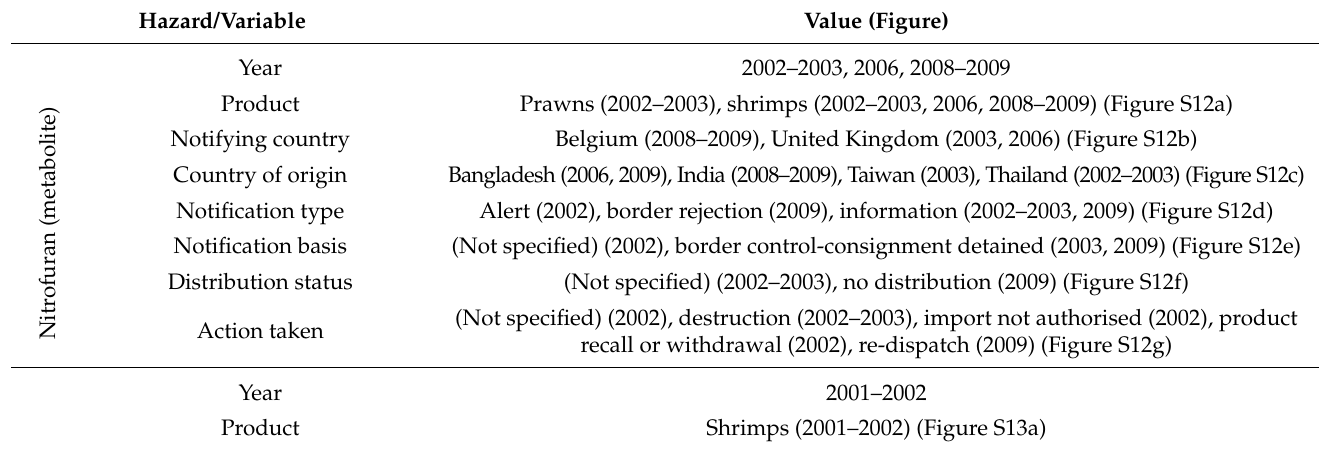
Table 7. Results of two-way joining cluster analysis related to notifications on veterinary products in seafood in the RASFF in 1996–2020.